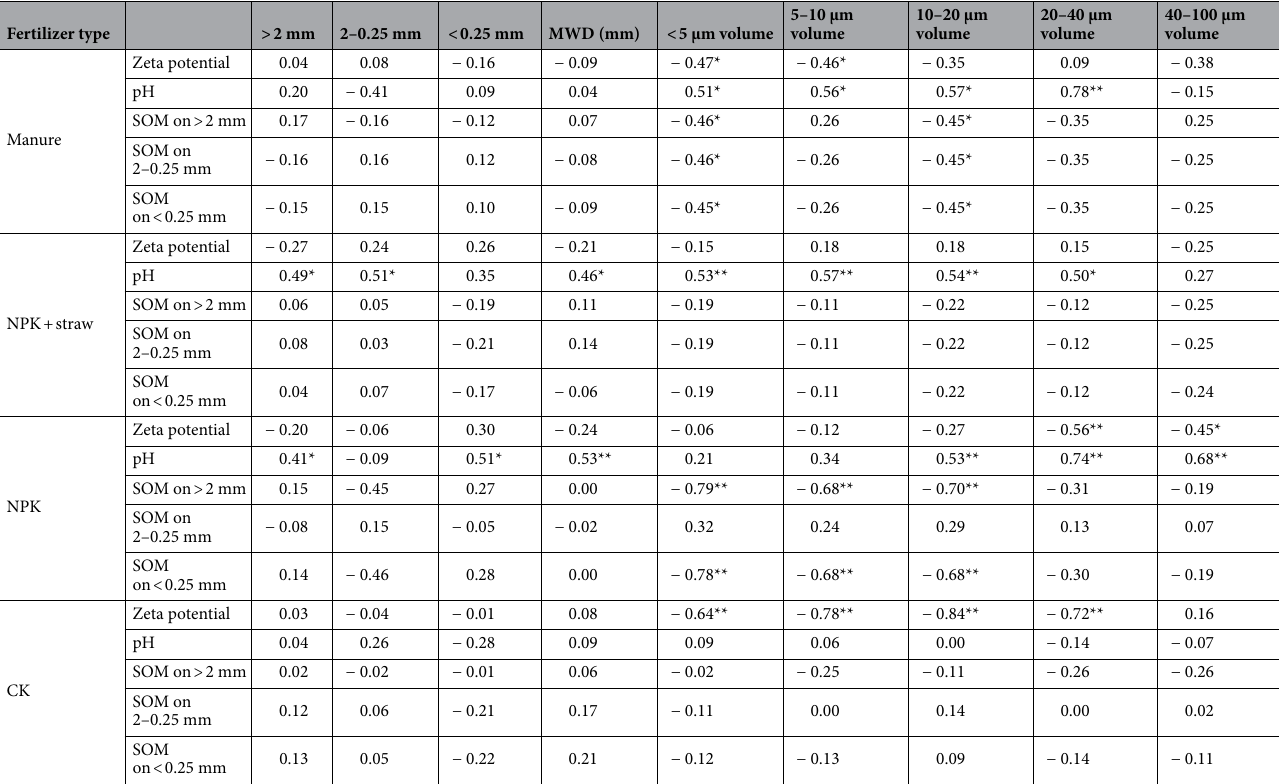
Table 3. Correlation among the measured soil parameters from all concentration under each type of fertilization. *Significant at α = 0.05; **Significant at α =